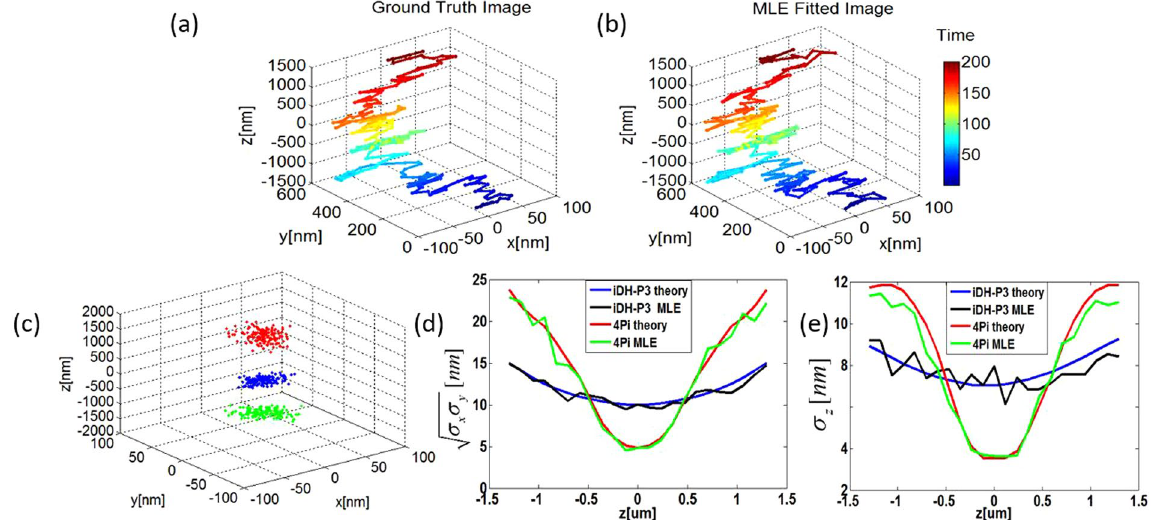
Figure 4. ( a ) Ground-truth trajectory of a single emitter, and ( b ) the reconstructed trajectory using the proposed interferometric-based system with a iDH-P3 PSF; ( c ) The reconstructed point clusters corresponding to three points with the ground-truth position at (0 nm, 0 nm, − 940 nm) (red), (0 nm, 0 nm, 0 nm) (blue), and (0 nm, 0 nm, 1300 nm) (green), respectively. ( d , e ) Comparisons of the proposed iDH-P3 PSF with the 4Pi in terms of estimation errors in the transverse ( d ) and axial ( e )